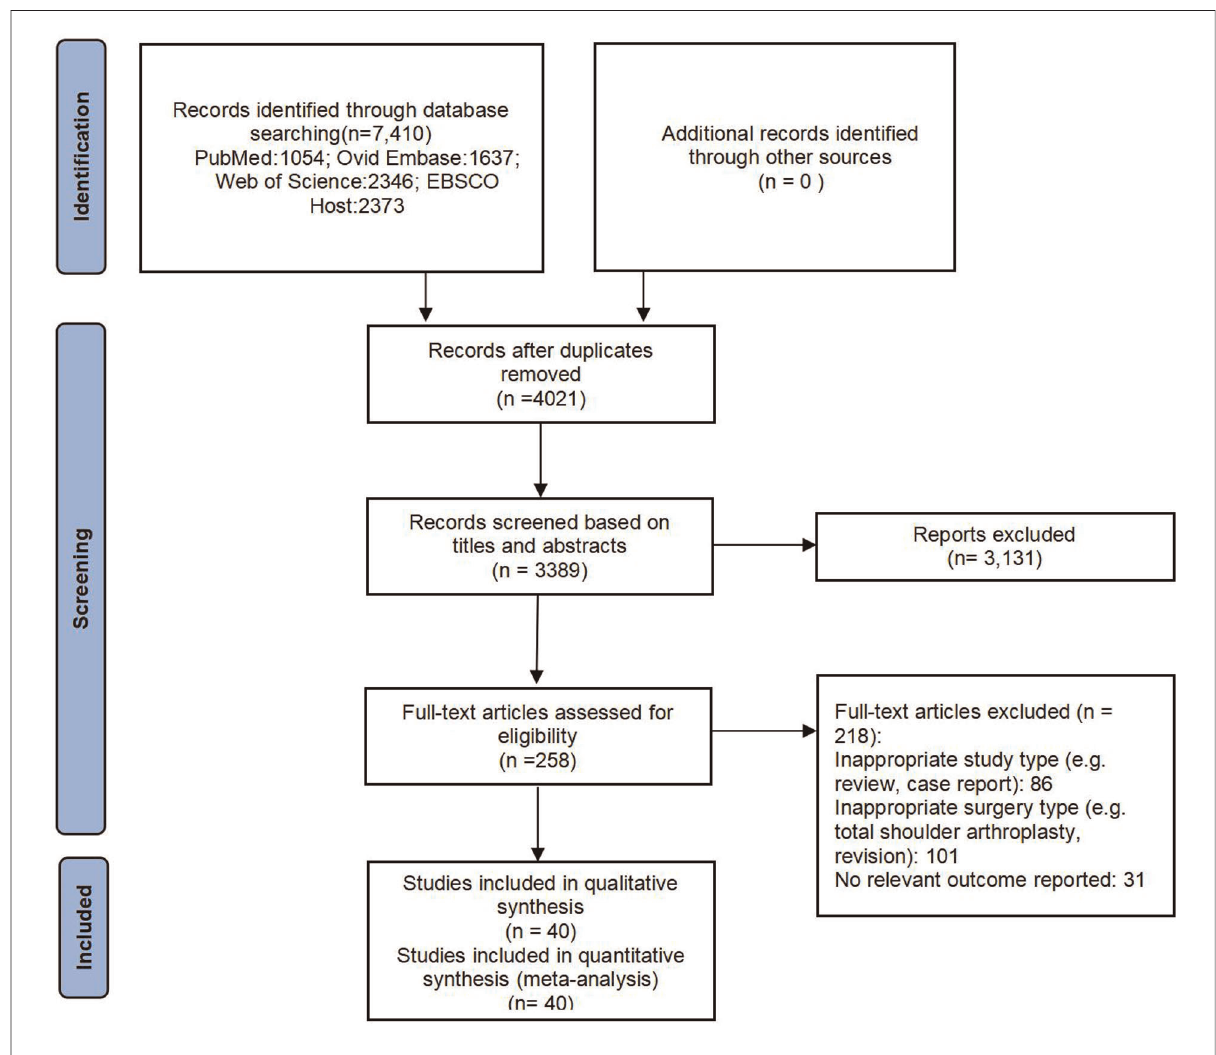
FIGURE 1 Flowchart of study identi fi cation, screening, and